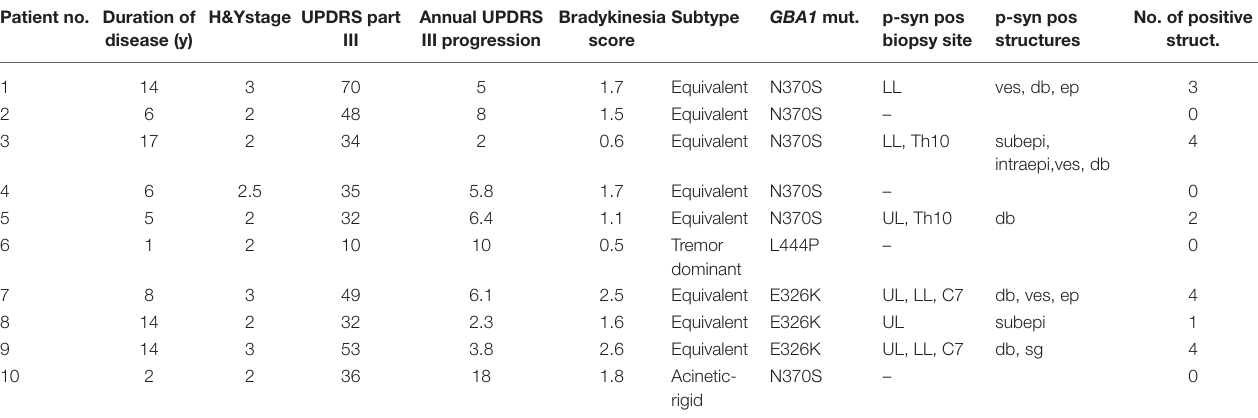
TABLE 1 | Demographic data and p-syn deposition of patients with GBA1 mutation.